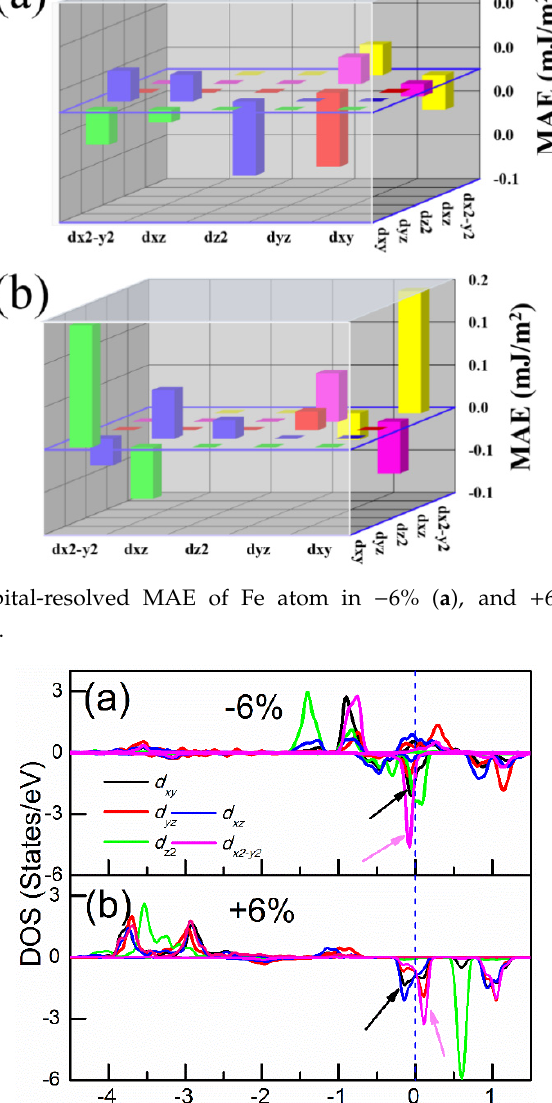
Figure 7. The d -orbital-resolved MAE of Fe atom in − 6% ( a ), and +6% ( b ) strains in C-1 stacking configuration.